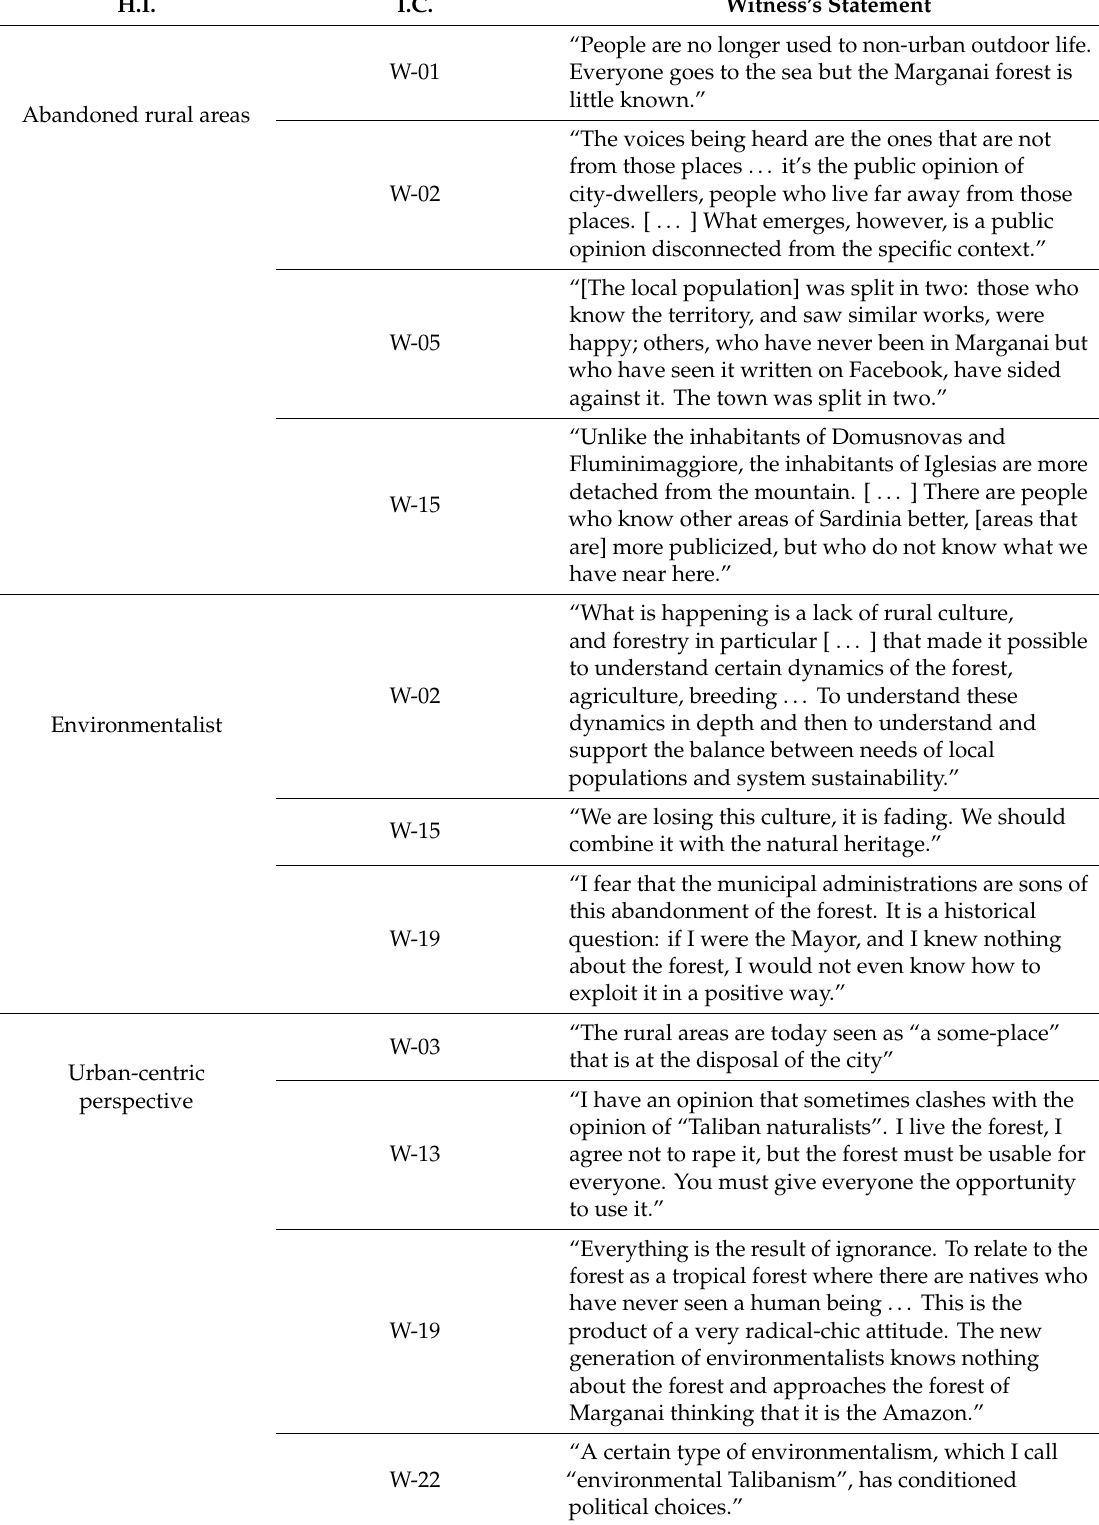
Table 4. Examples of homogeneous information (H.I.) about the intergenerational cultural erosion.